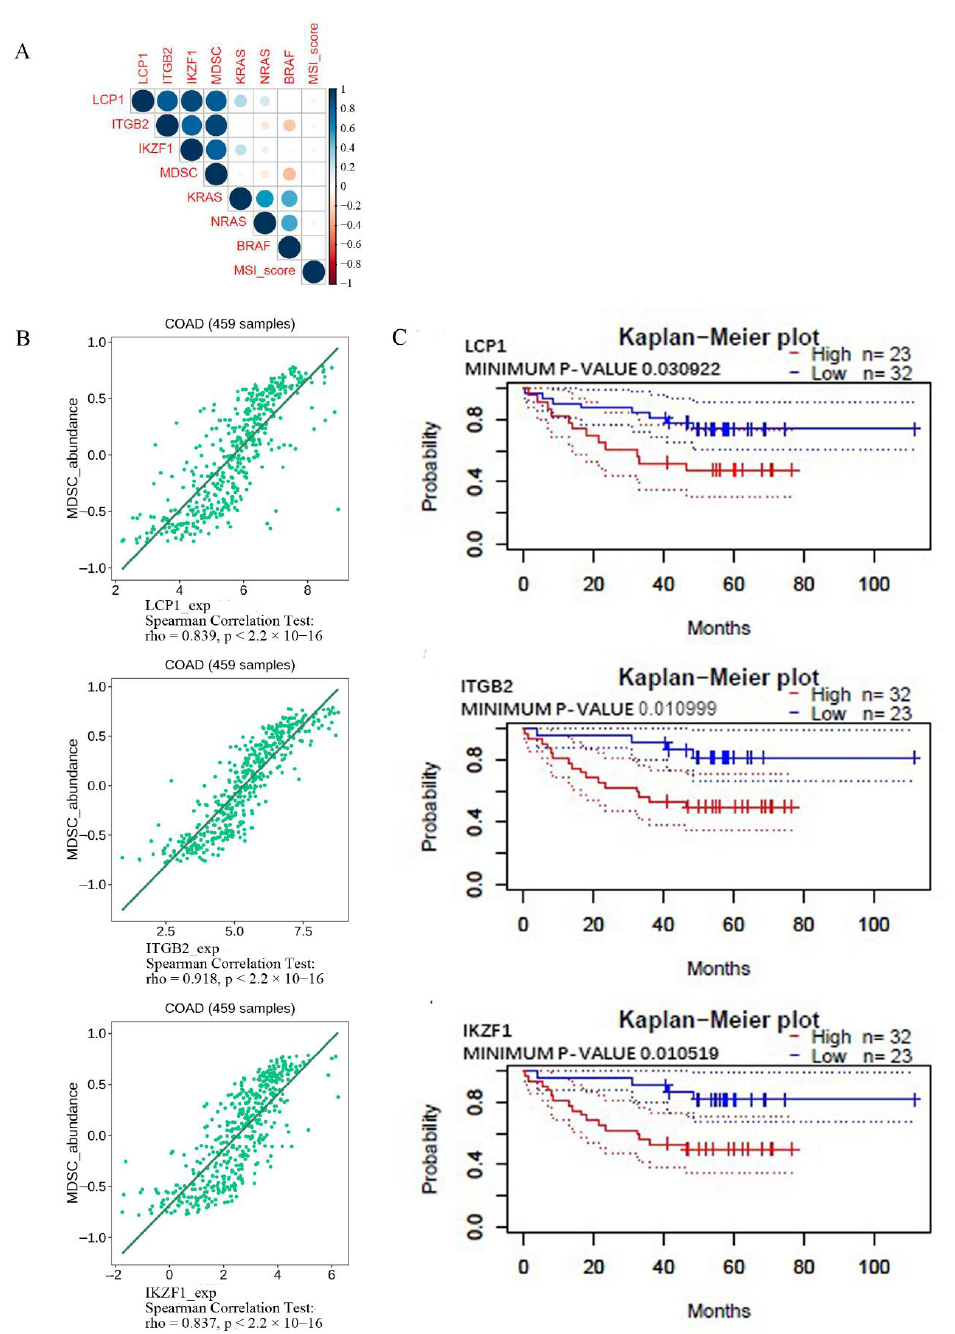
Figure 7. ( A ) The respective correlation among critical gene expression, MDSC, KRAS, NRAS, BRAF and MSI score in COAD of TCGA was analyzed using the corrplot R package. ( B ) Relations between the abundance of myeloid-derived suppressor cells and the expression of LCP1, ITGB2, and IKZF1. The immune-related signatures of MDSC are available on the TISIDB website. ( C ) The overall survival rate. A logrank test was used for analyzing Kaplan–Meier curves stratified by the indicated mRNA levels. Colorectal cancer survival was correlated with genes evaluated in the PrognoScan database.